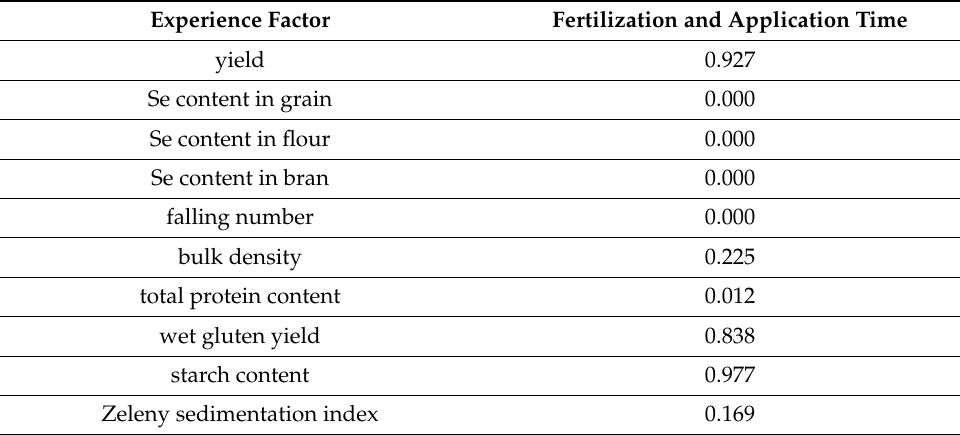
Table 2. Influence of the experimental factor on the analysed values.